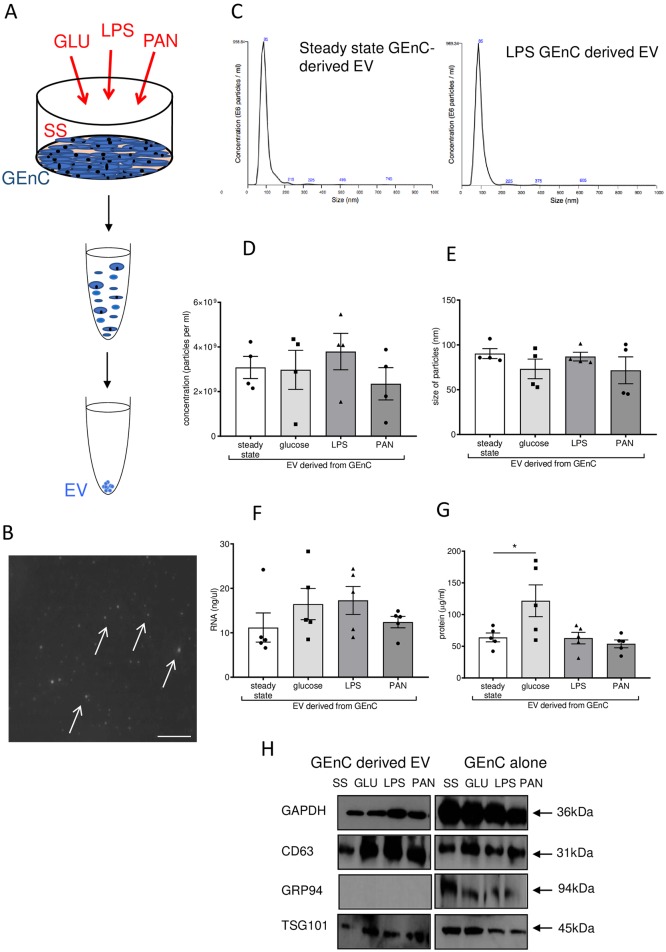
Characterisation of GEnC derived EV.A) Illustration of the UC technique for EV isolation. Briefly, GEnC cultures were supplemented with exosome free FBS and media collected 24 hour post stimulation with glucose, LPS or PAN, or GEnC were kept at steady state (control). Successive centrifugation steps at 300g, 2,000g and 10,000g removed cells, cell debris and microvesicles. UC was performed twice at 100,000g to precipitate a pure EV fraction. B) Snapshot of steady state GEnC derived EV as visualised by Nanosight 405nm excitation. Arrows indicated vesicles. Scale bar represents 1μm. C) Representative size distribution and concentration of EV isolated from steady state and LPS treated GEnC via UC, as performed on the Nanosight LM10 instrument. D). The concentration and E) size of vesicles of from steady state, glucose, LPS and PAN GEnC derived EV n = 5. F) RNA and G) protein concentration of steady state, glucose, LPS and PAN derived GEnC EV n = 5. * represents P<0.05. H) Protein western blots of exosomes derived from SS (steady state), GLU (glucose), LPS or PAN treated GEnC using antibodies for GAPDH, CD63, GRP94, and TSG101 performed under reducing conditions.